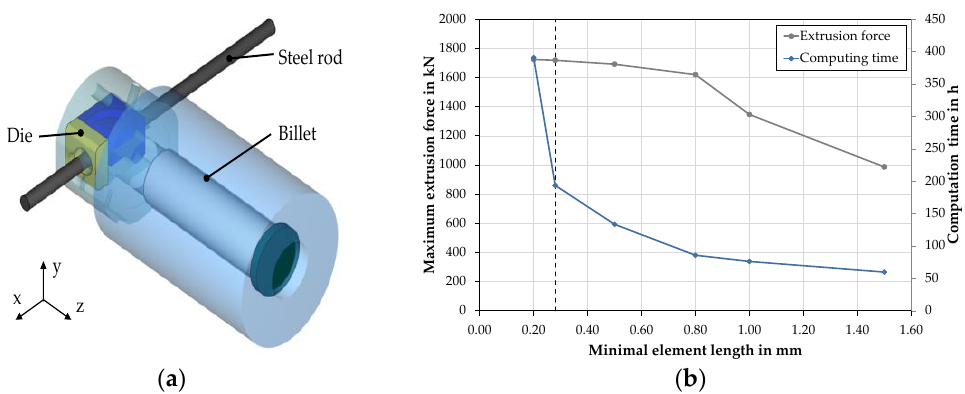
Figure 2. ( a ) 3D FE model of the assembly; ( b ) Influence of the minimal element edge length on the predicted extrusion force and computation time.